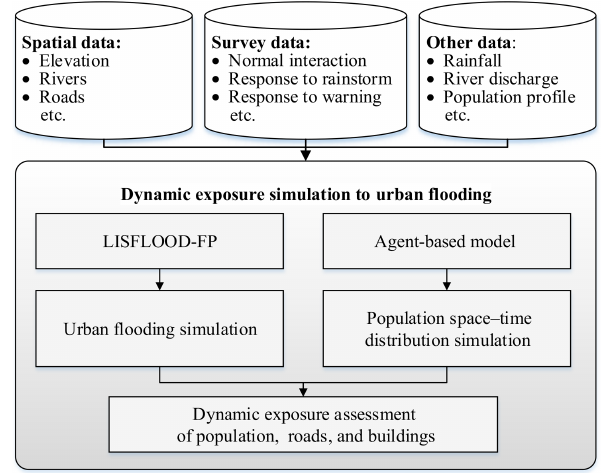
Figure 2. Overview of the dynamic exposure simulation to urban